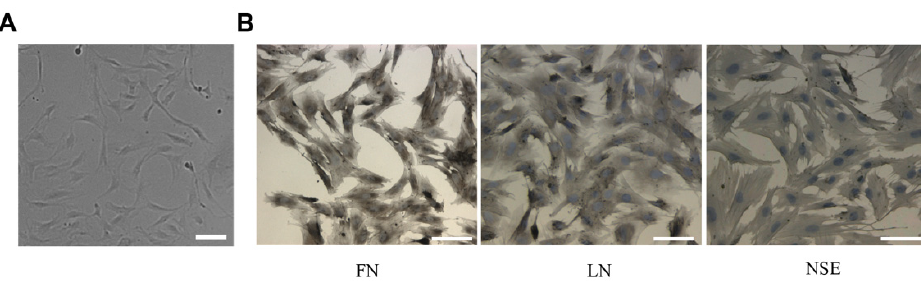
Figure 3. The primary cultured TM cells identification. ( A ) Phase ‐ contrast microscopic images of TM cells. The image showed that the cell morphology is mainly spindle ‐ shaped. ( B ) TM cell biomarker proteins were detected by the immunohistochemical method. The immunohistochemical images of TM cell biomarkers—FN, LN, and NSE showed that the cells positively express FN, LN, and NSE. Scale bar: 50 μ m.